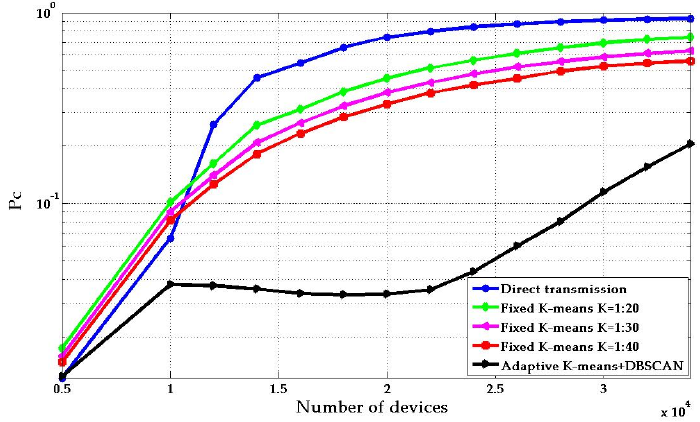
Figure 3. Collision probability.